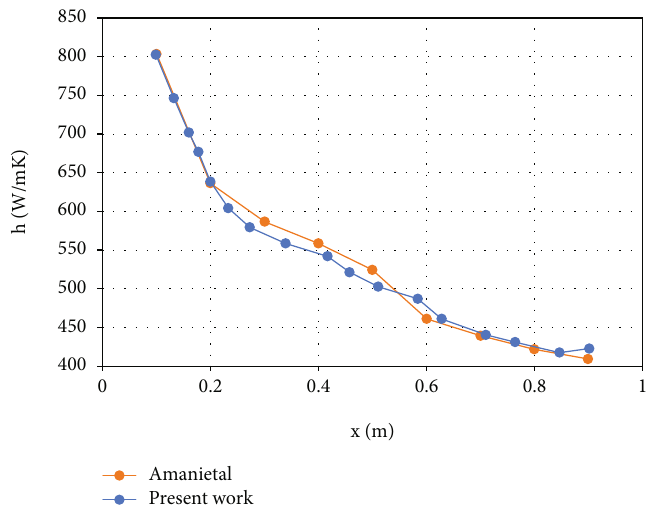
Figure 3: Check the validity of the results with Amani et